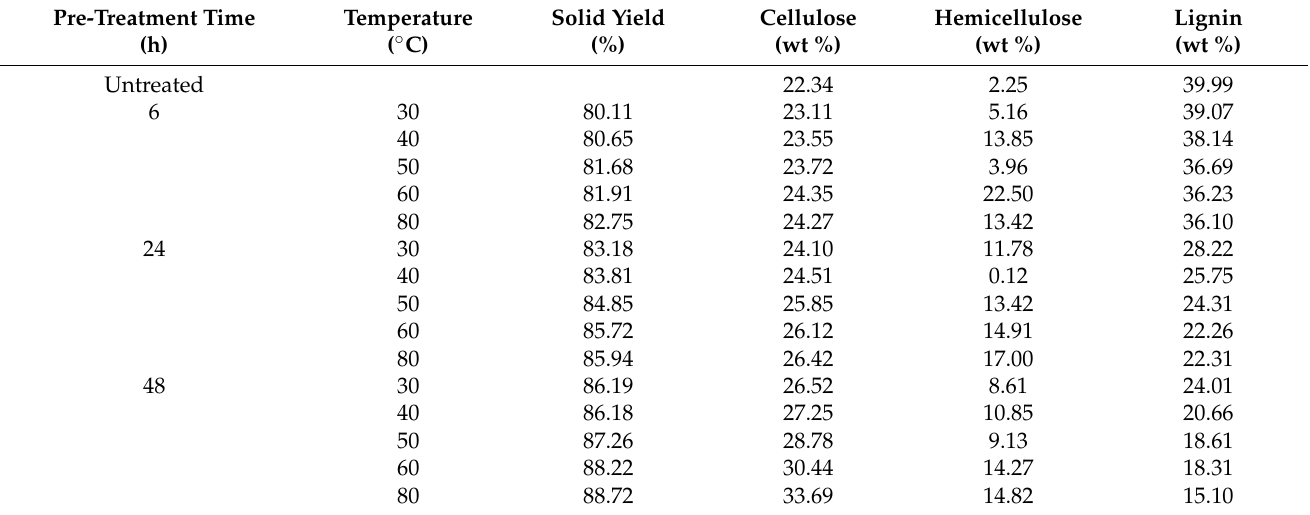
Table 1. Effect of various HP Pretreatment temperatures and times on the rice husks composition. Pre-Treatment Time